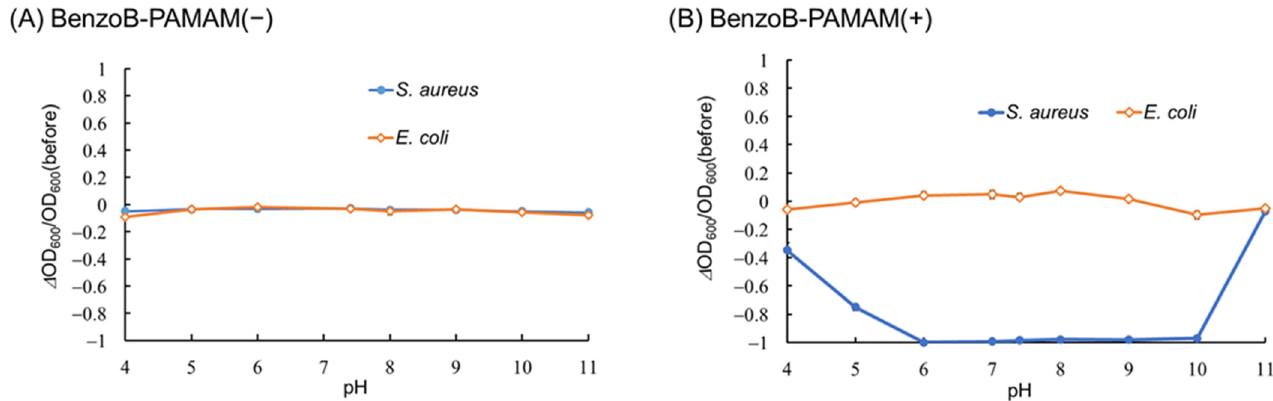
Figure 4. Turbidity changes in bacterial suspensions containing BenzoB-PAMAMs in PBS ( n = 3). [BenzoB-PAMAM( − ) or BenzoB-PAMAM(+)] = 3.3 × 10 − 6 M. [ S. aureus IAM1011 or E. coli K12W3110] = 2.3 × 10 8 CFU · mL − 1 . Bars represent the SD in three separate experiments. ( A ) BenzoB-PAMAM( − ).